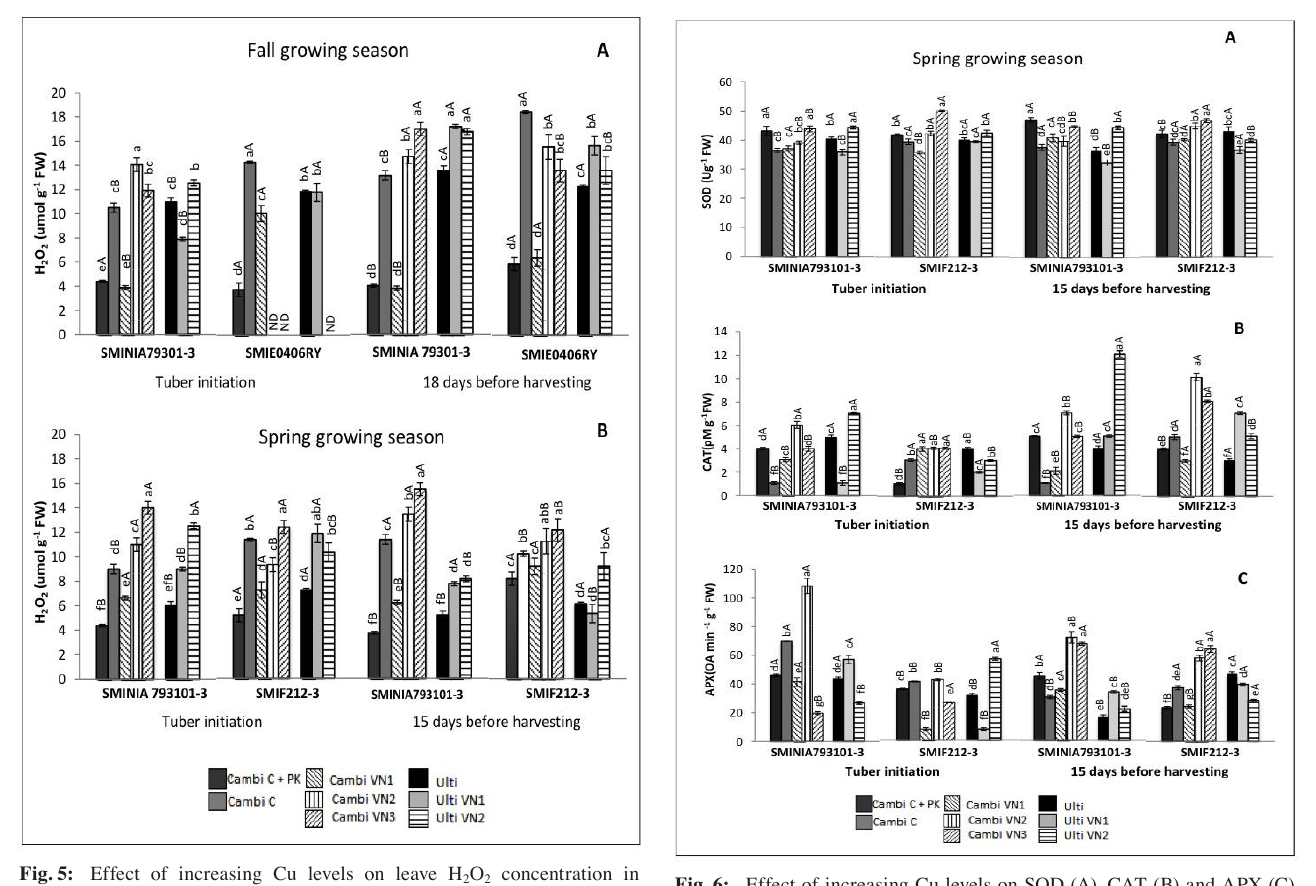
Fig. 6: Effect of increasing Cu levels on SOD (A), CAT (B) and APX (C) leave activities in different development stages (tuber initiation and 15/18 days before harvesting) of different potato genotypes at spring growing season. Data represent the mean ± S.D. of six replicates. Different lowercase letters indicate significant differences between Cu levels in the same potato genotype (p < 0.05). Different capital letters indicate significant differences between potato genotypes at the same Cu level (p <